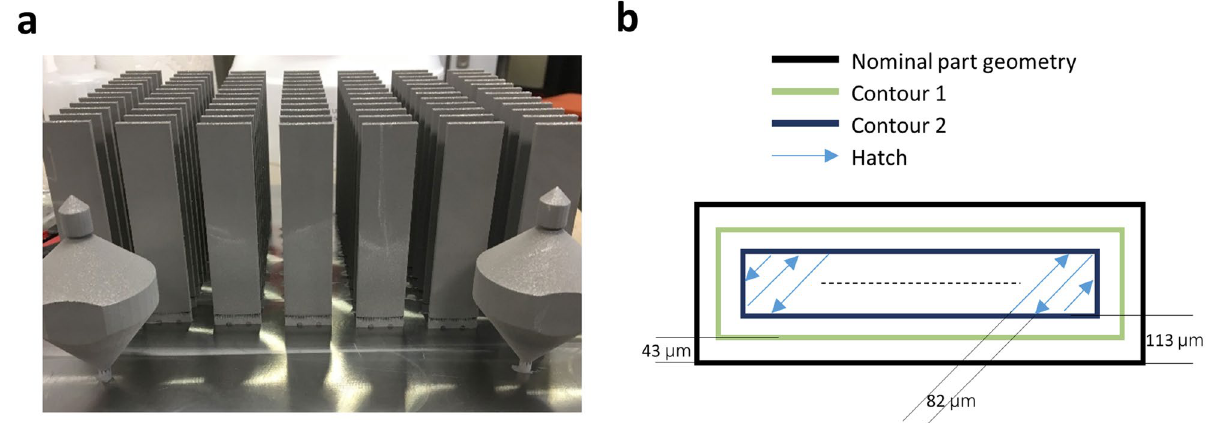
Figure 4. (a) Vertically built samples, which have an as-built dimension of 21.08 mm × 2.54 mm × 84.58 mm. (b) Printing strategy: the figure shows the cross-section for the vertically built sample (not to scale). The hatch orientation rotates 245 degrees between layers. The black line is the as-designed part geometry. This line does not get scanned. Instead, the machine offsets the contours so that the edge of the contour 1 (green line) melt pool sits on the nominal part geometry. The order of scanning is contour 1, contour 2 and hatching. Here, the scan speed for the contour 1 and contour 2 were constant at 3000 mm/s. But hatching speed varied from 750 to 2000